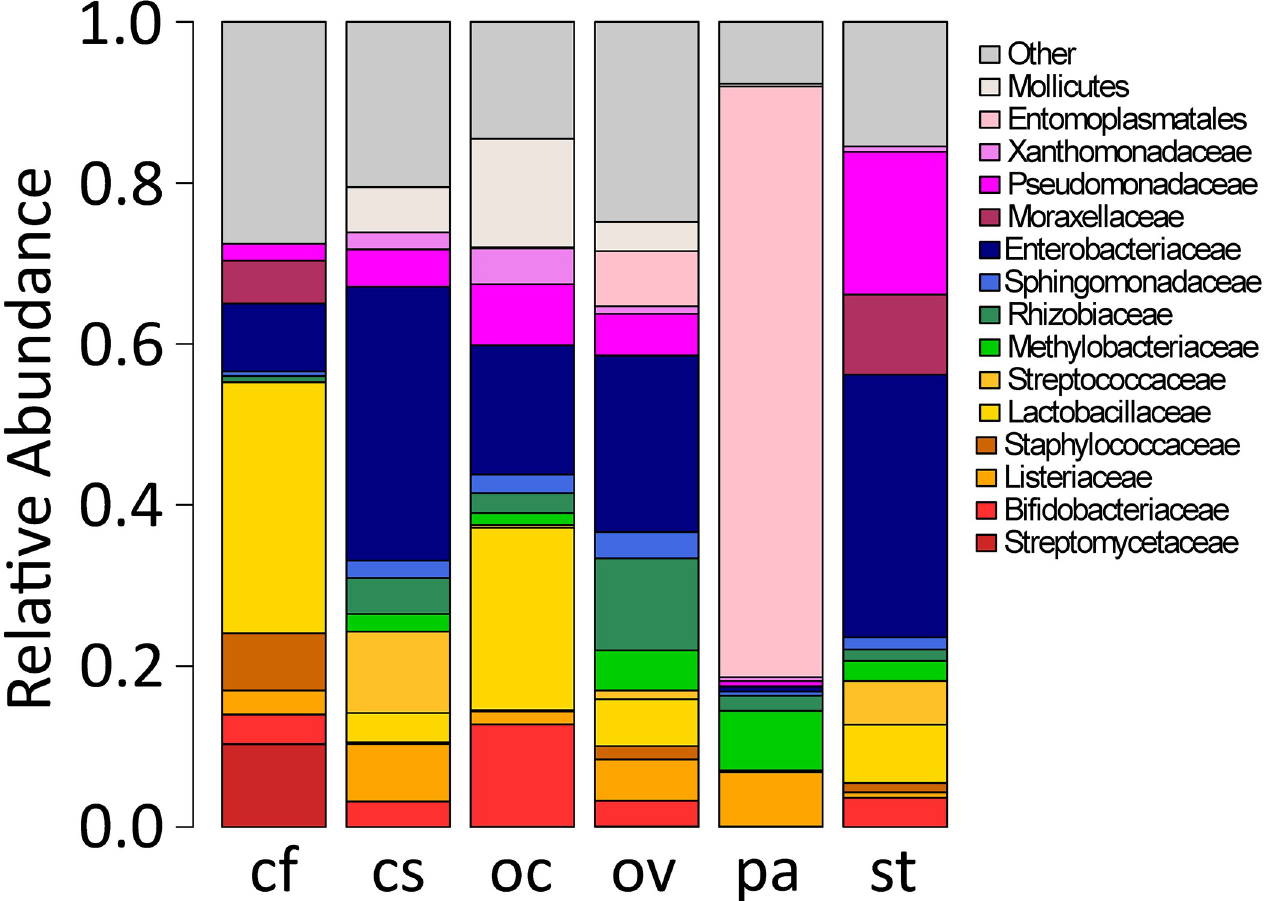
Fig 2. Mean relative abundance of prevalent bacterial families in the gut of six grasshopper species. The abbreviations for grasshopper species that appear on the x axis are as follows: cf, C . fasciatus ; cs, C . strictus ; oc, O . concinnum ; ov, O . vulgare ; pa, P . atlantica ; and st, S . texensis . Bacterial families with mean relative abundance < 1.5% across each grasshopper species are grouped together as “other.” For specific values, see S3 File.